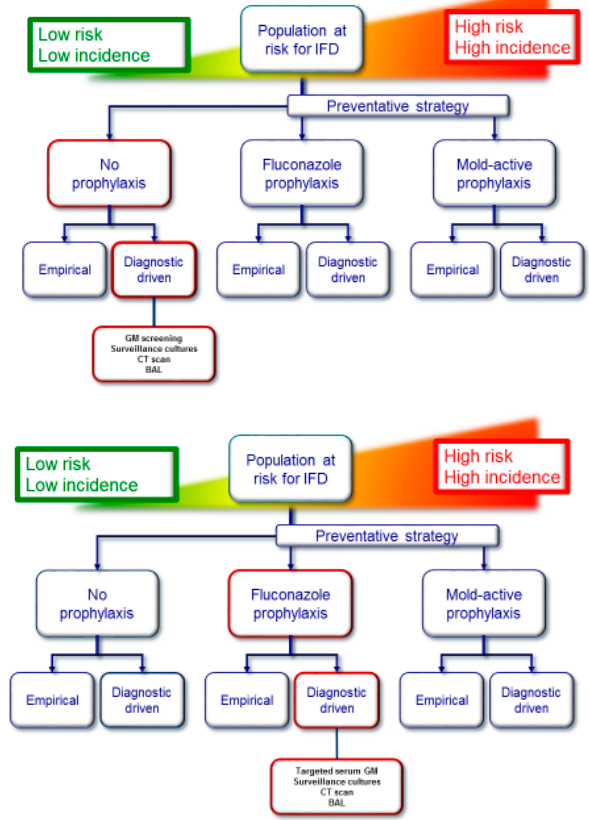
Figure 4. Radboudumc diagnostic driven pathway with a lower at-risk population for IA; pathway follows red tiles. Pre: before this analysis, using no standard antifungal prophylaxis. Post: after this analysis, alternative using standard fluconazole prophylaxis and targeted serum GM only to confirm suspected IA. This figure was adapted with permission from Agrawal et al. [8].